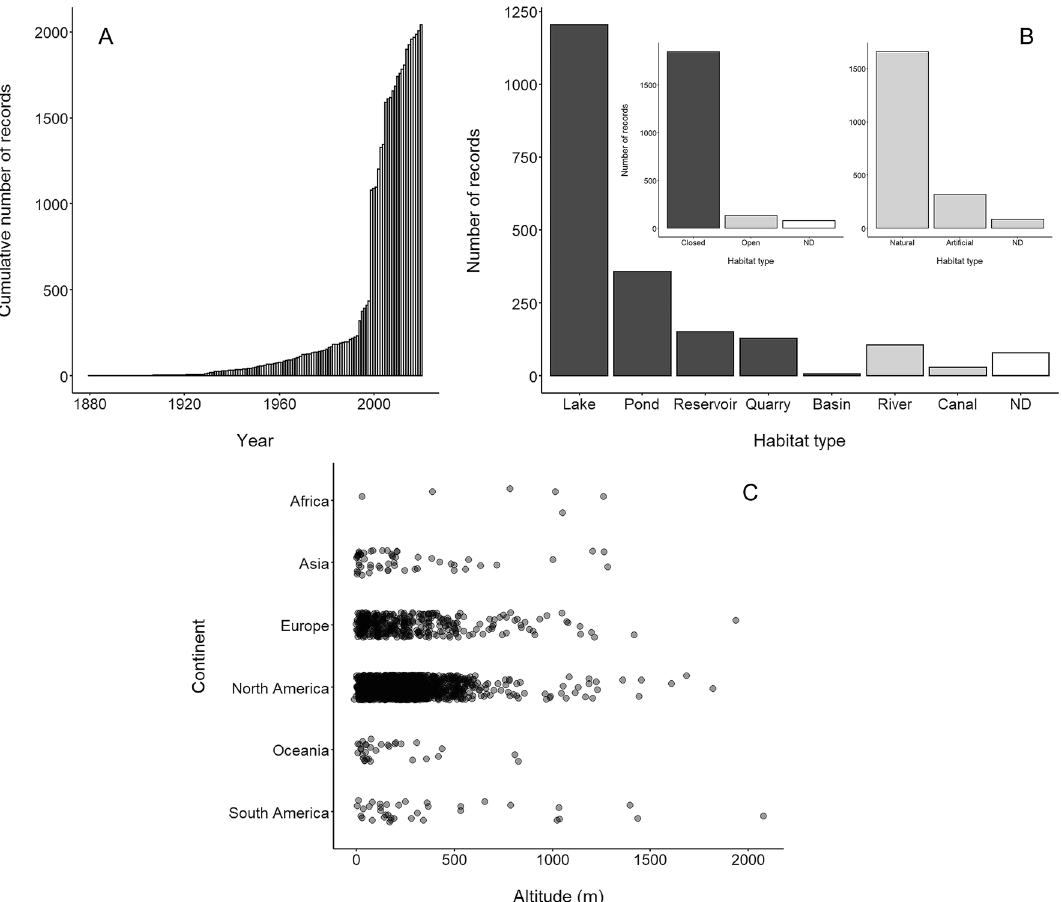
Figure 1. ( A ) Succession of the cumulative number of Craspedacusta sowerbii records worldwide, ( B ) habitat affinities (dark grey: closed systems, light grey: open systems, white: no data; ND), and ( C ) altitude of freshwater systems with C. sowerbii